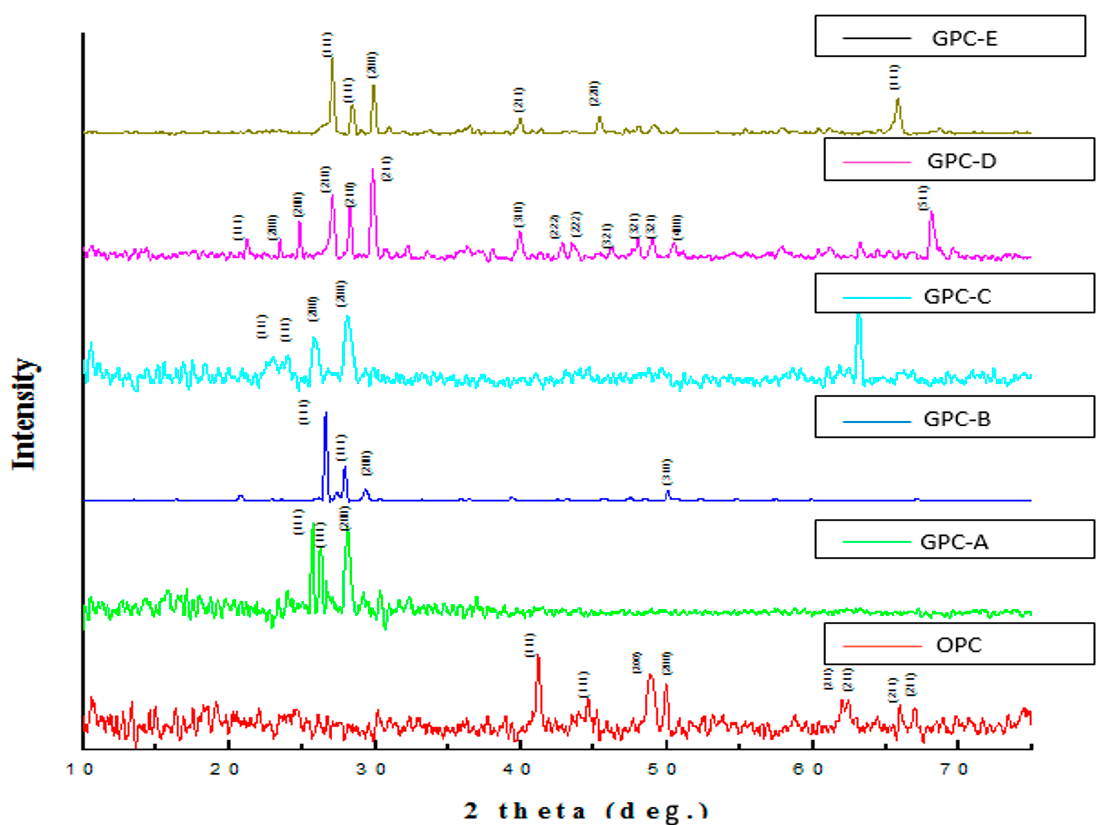
Figure 9. XRD pattern of OPC and QFS-GPC specimens.